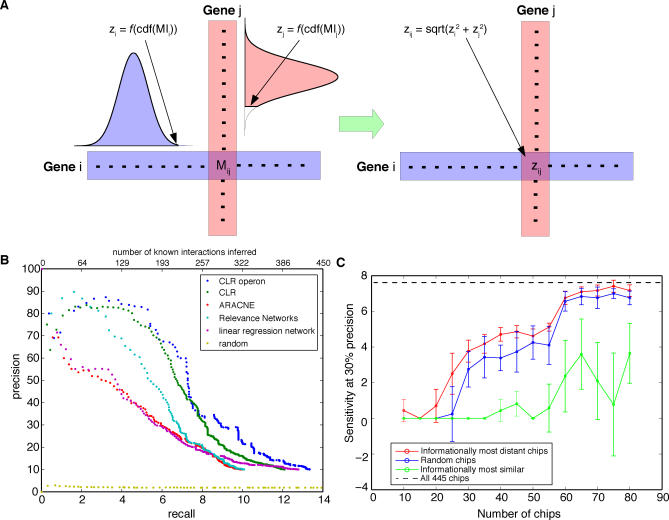
The CLR Algorithm: Methods and Comparison to Other Approaches(A) A schema of the CLR algorithm. The z-score of each regulatory interaction depends on the distribution of MI scores for all possible regulators of the target gene (zi) and on the distribution of MI scores for all possible targets of the regulator gene (zj).(B) Precision and recall for several different network inference methods applied to all genes in the E. coli microarray compendium were calculated using RegulonDB. The number of correctly inferred interactions (within RegulonDB) for each recall value is labeled on the top of the chart. All algorithms performed far better than the random method. Both CLR and relevance networks reach high precisions, but CLR attains almost twice the recall of relevance networks at some levels of precision.(C) Using 60 well-chosen arrays, we can infer a network, nearly equivalent in recall and precision to the network inferred using all 445 microarrays in the compendium (dotted horizontal line), reflecting the redundancy of the compendium and the potential for improvement in choosing subsequent perturbations to profile.